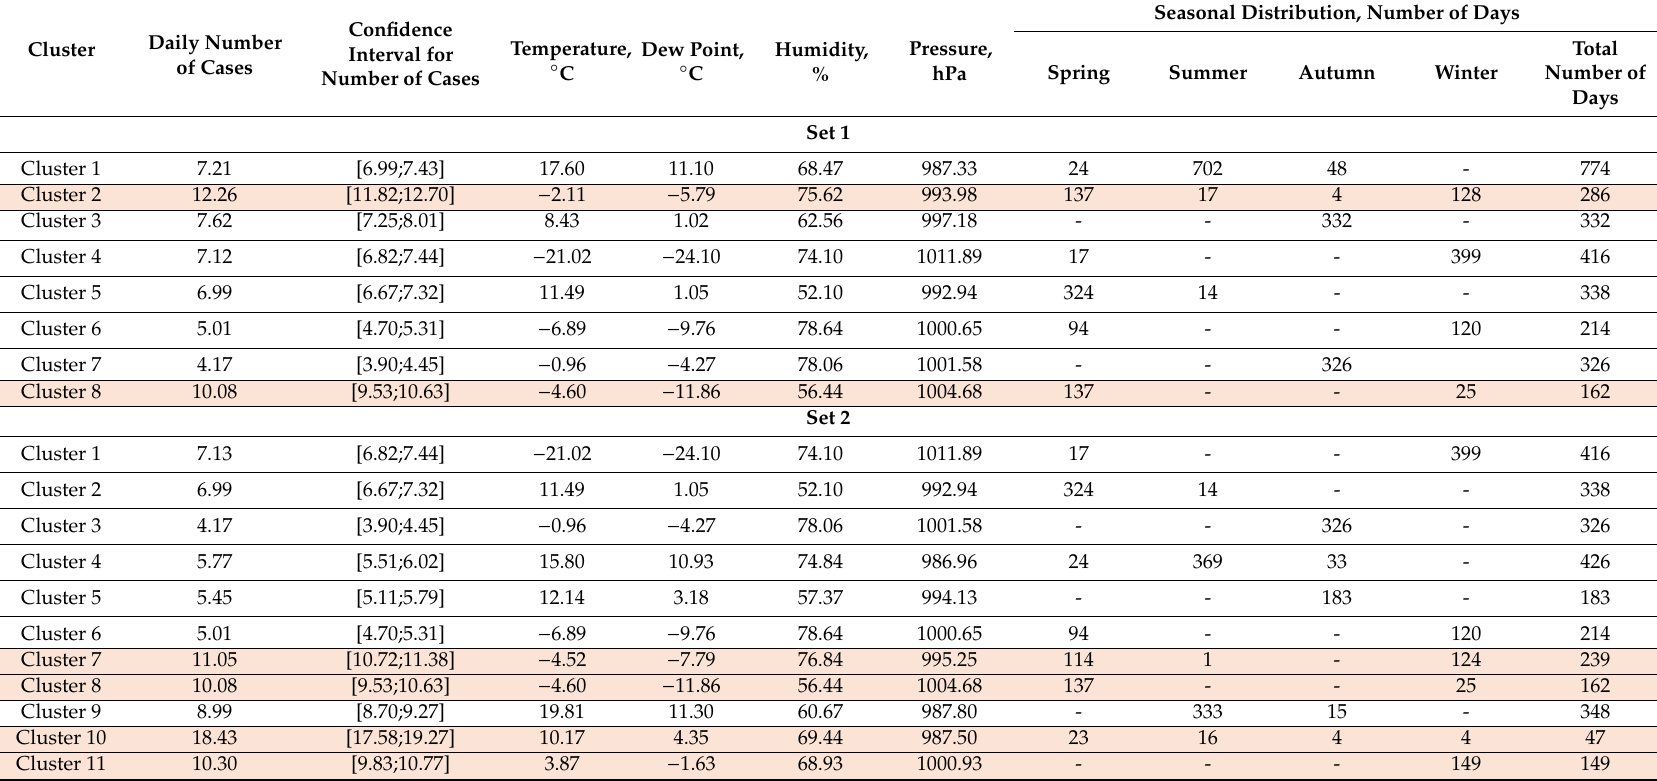
Colored rows refer to clusters with the high disease